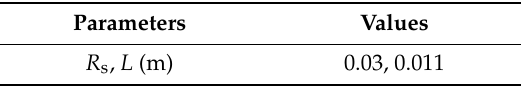
Table A2. The model parameters of SFD.